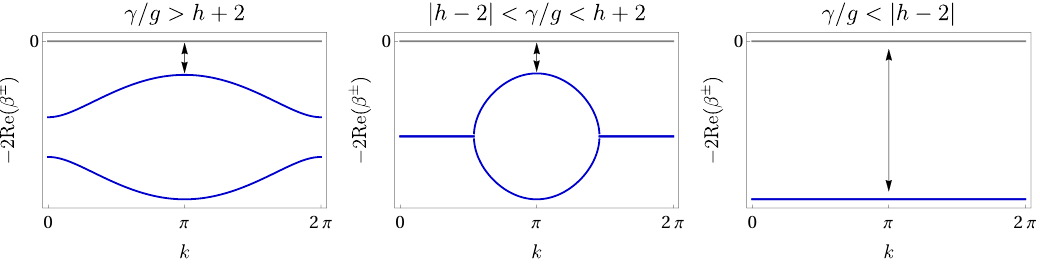
Figure 2: Band structure for the elementary excitations of the Liouvillian L for the topological model, with α = 1. Depending on the relative values of γ/ g and h , there are three regimes : two bands (left), one band (right), and an intermediate regime (middle). The black arrow represents the spectral gap ¯ λ in each